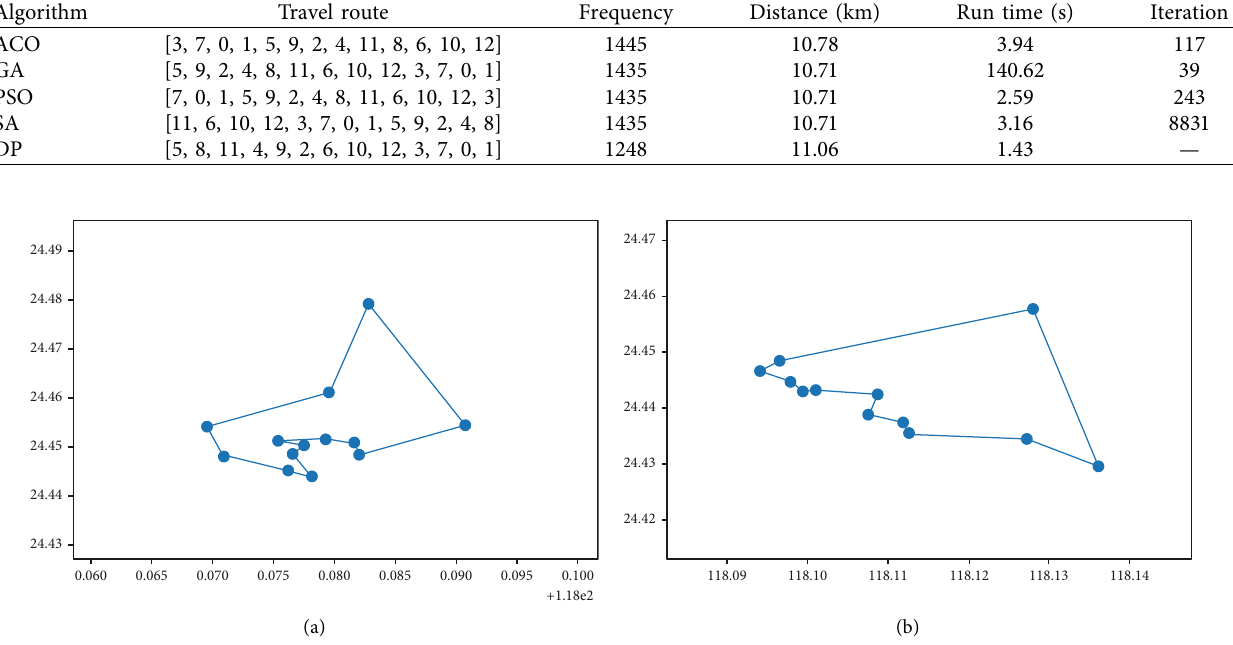
Figure 8: Optimal travel routes in Xiamen. (a) Optimal travel route in the Gulangyu tourism area. (b) Optimal travel route in the Beach tourism